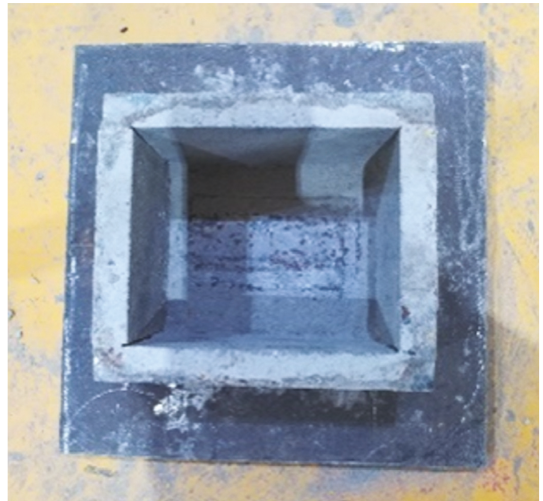
Figure 4: Head plate on the ends of specimens.